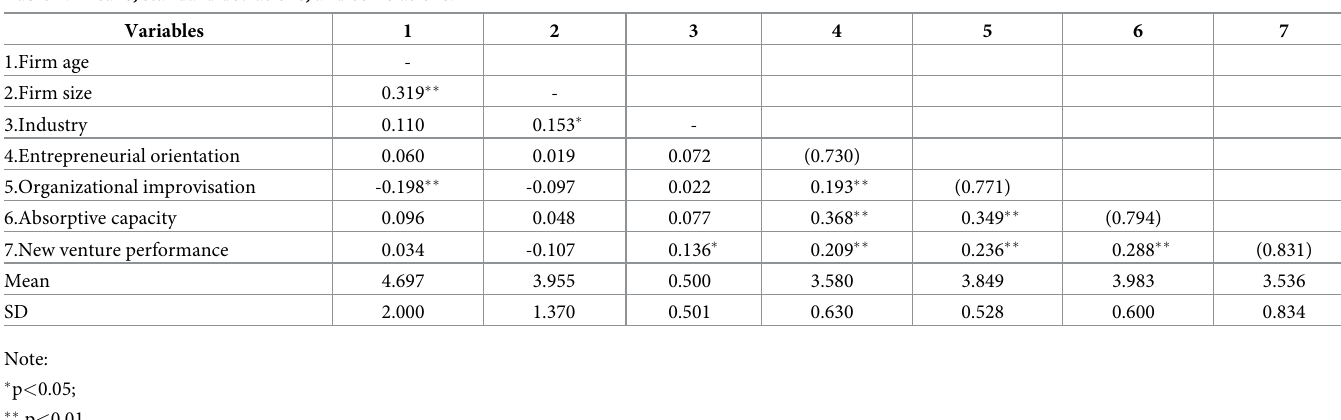
Table 1. Means, standard deviations, and